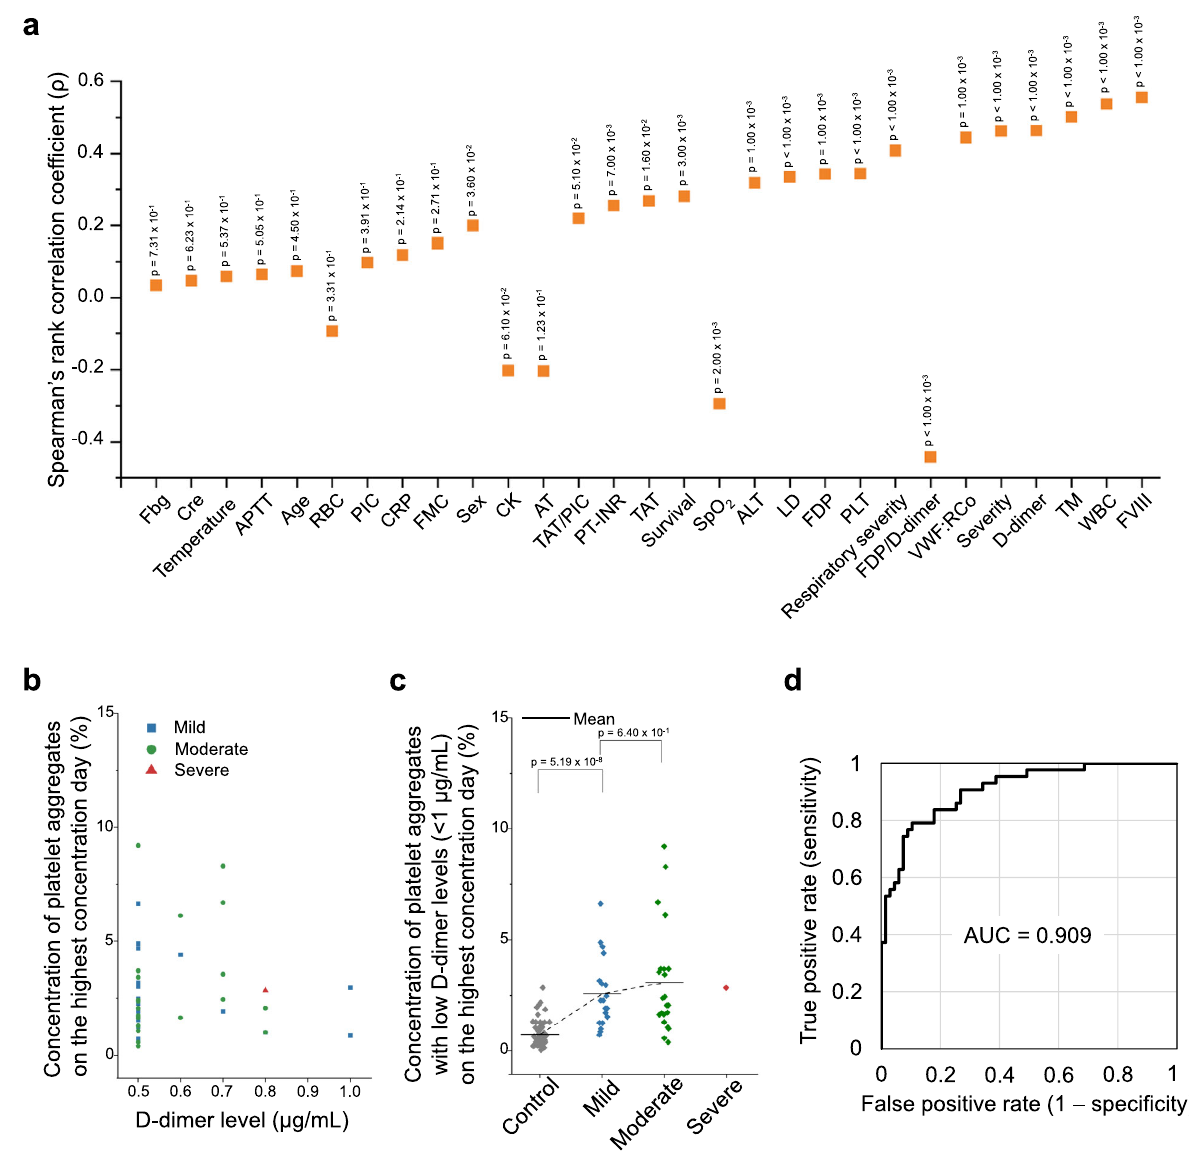
Fig. 5 Comparison with clinical laboratory tests. a Comparison of the platelet aggregate concentration measured on the highest concentration day with clinical laboratory and physical fi ndings. WBC leukocyte count, RBC red cell count, PLT platelet count, APTT activated partial thromboplastin time, PIC plasma plasmin- α 2-plasmin inhibitor complex, CRP C-reactive protein concentration, FMC fi brin monomer complex, CK creatinine kinase, AT antithrombin, PT-INR prothrombin time international normalized ratio, TAT thrombin antithrombin complex, SpO 2 oxygen saturation, ALT alanine transaminase concentration, LD lactate dehydrogenase concentration, FDP fi brinogen/ fi brin degradation product, VWF:RCo von Willebrand factor activity, TM thrombomodulin, FVIII coagulation factor VIII activity, Temperature body temperature, Fbg fi brinogen level, Cre creatinine concentration. Exact p values were obtained using the spearman ’ s rank correlation test (two-sided) and shown in the fi gure. b Concentrations of platelet aggregates of patients